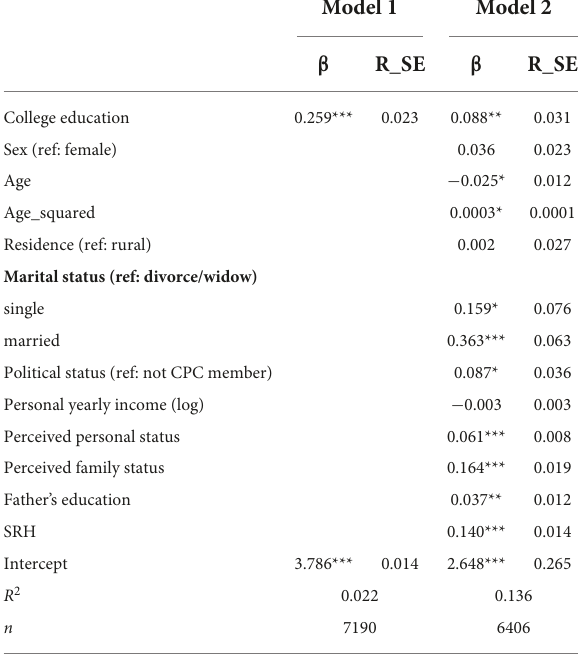
TABLE 4 Association between college education and happiness, based on OLS.